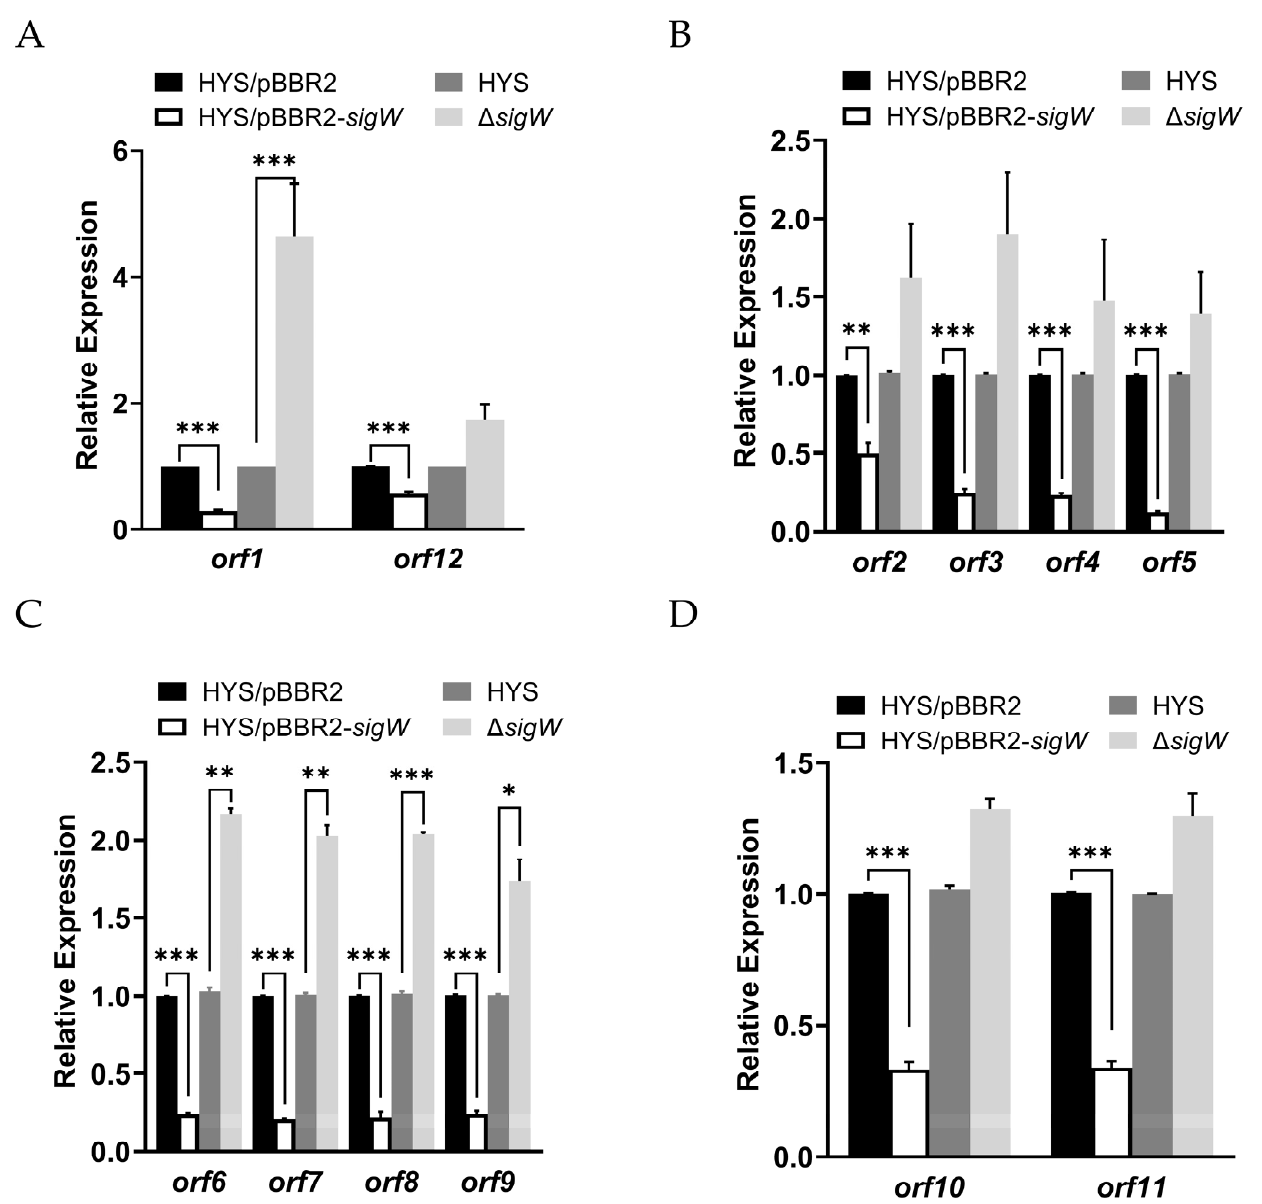
In order to further determine the regulatory mode of SigW on nfs cluster, the transcrip- Figure 5. SigW binds directly to promoters on the nfs cluster for regulatory action. Localization map tional levels of the five operons in the deletion and overexpression strains were detected of promoters on the nfs cluster ( A ). The electrophoretic mobility shift assay shows that SigW binds by the qRT-PCR method. Consistent with the RNA-seq data, the expression levels of the to the promoter region of the wild-type ( B ) orf1 , ( C ) orf2 – 5 , ( D ) orf9 – 6 , ( E ) orf10 – 11 , and ( F ) orf12, five operons were significantly downregulated without exception when sigW was overex- respectively. Each reaction mixture contained 0.3 μ M PCR products of the wild-type orf1 –217 to –1, pressed, while their expression levels were increased in the ∆ sigW strains (Figure 6). To orf2 –191 to –1, orf9 –225 to –1, orf10 –237 to –1, orf12 –246 to –1, and PD2720 –210 to –1. The protein sum up, these results indicated that SigW represses nfs cluster expression directly under concentrations are indicated above the lane. BSA and P-2720 were used as negative controls. Data the iron-restricted environment. are representative of three independent replicates.